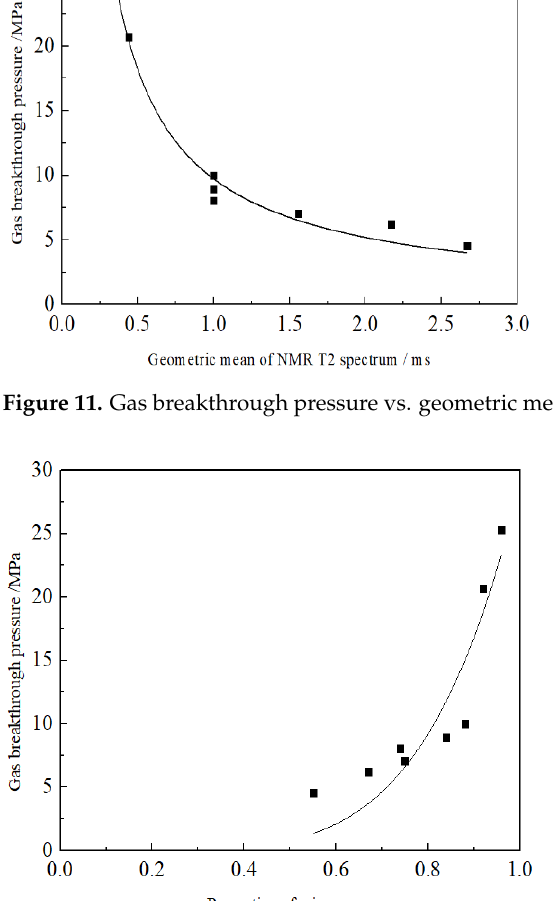
Figure 13. Linear relation between predicted gas breakthrough pressure and measured gas break- through pressure. 5. Application The shale breakthrough pressure calculation method based on low-field NMR, unlike the methods based on conventional logging data (e.g., acoustic and resistivity) which do